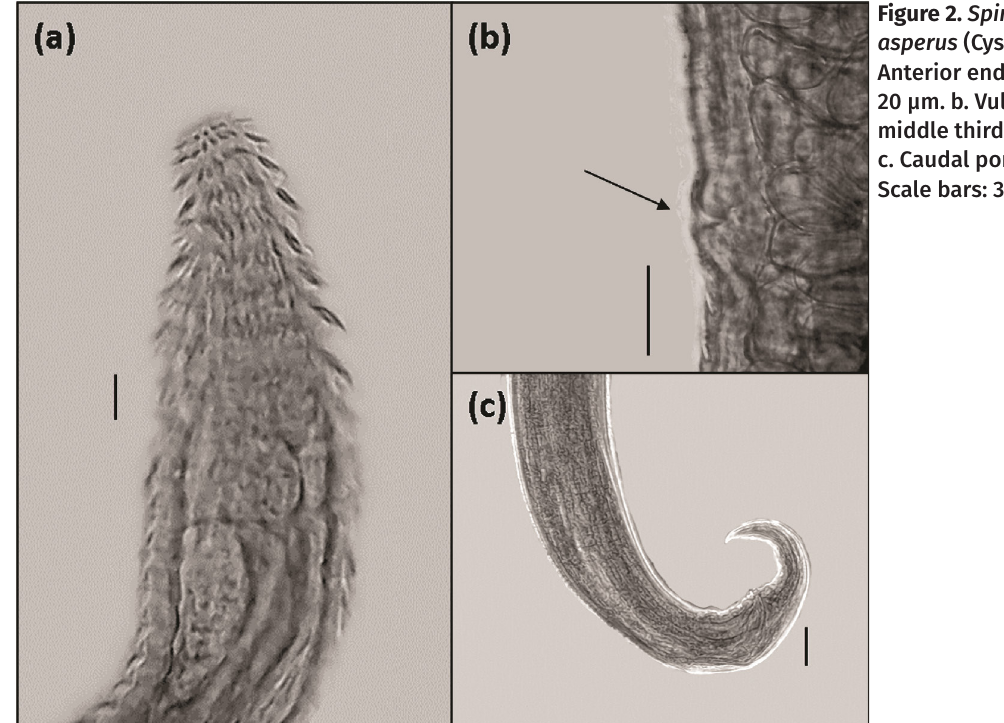
233.9 (158-291, n = 11). Distance from the anterior end to the first ring of spines: 10 (n = 1). Distance between the first ring of spines and the second: 9.2 (6-10, n = 8); between the second and third rings: 10 (8-15, n = 8) and between the third and fourth: 13.4 (7-18, n = 8). Distance from the last ring of spines to posterior end: 31 (29-33, n = 2). Ring spines length: 12.6 (9-17, n = 14). Length of prostomium: 147 (121-173, n = 2). Long muscular esophagus: 62 and long glandular esophagus: ellipsoidal eggs, 29.6 long (22-42, n = 12) and filaments. Tail length: 204.4 (130-281, n = 5).